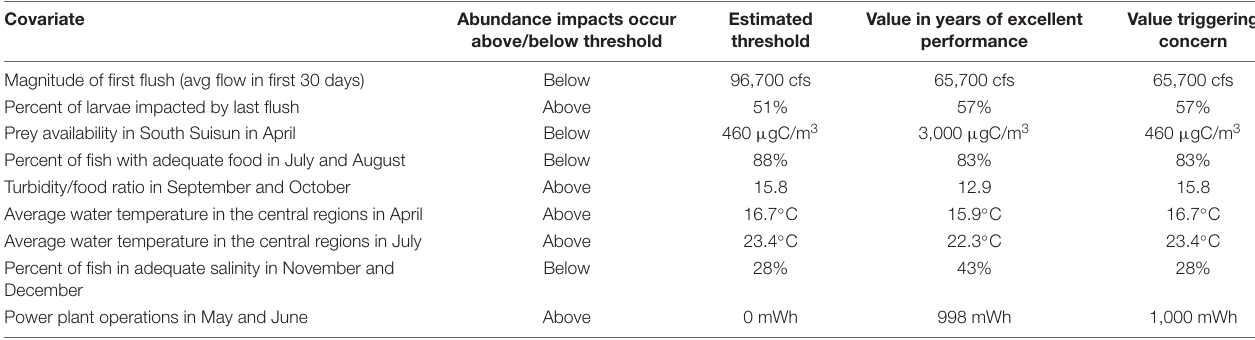
TABLE 6 | Thresholds at which factor conditions likely influence abundance of delta